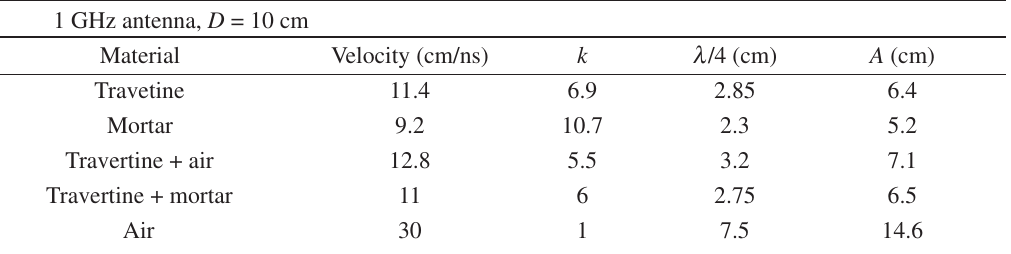
Table I. The travertine, mortar and empty space (air) EM properties with vertical resolution l /4 and footprint radius A . 1 GHz antenna, D = 10 cm